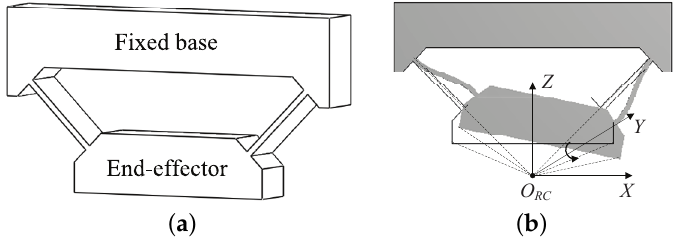
Figure 1. The leaf-type isosceles-trapezoidal flexural (LITF) pivot. ( a ) Structure of the LITF pivot; ( b ) Working principle of the LITF pivot.